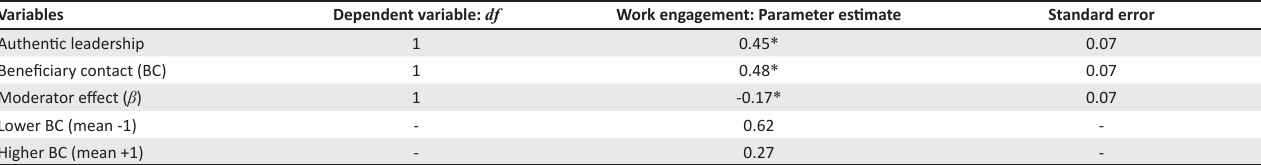
TABLE 2: Linear relationship and moderating effect. Variables